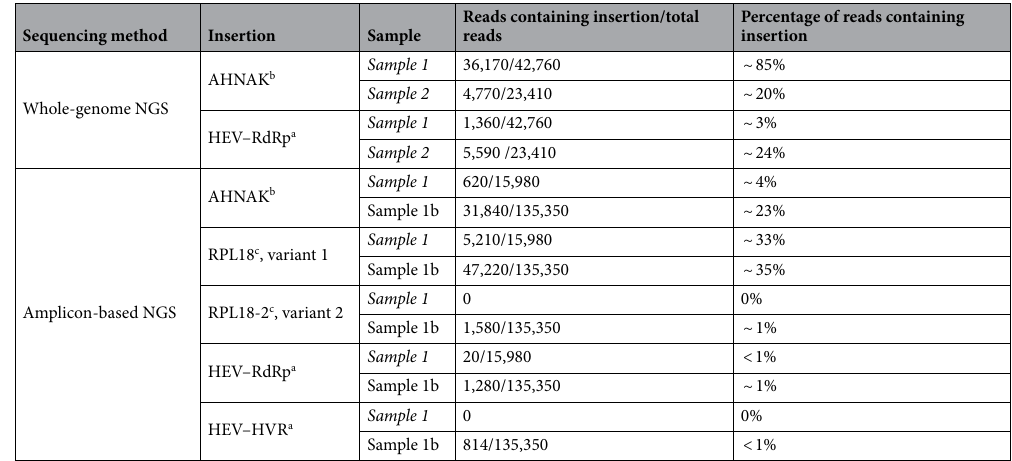
Table 4. Proportions of reads supporting insertions. a Using wbGER27 as reference (accession No: